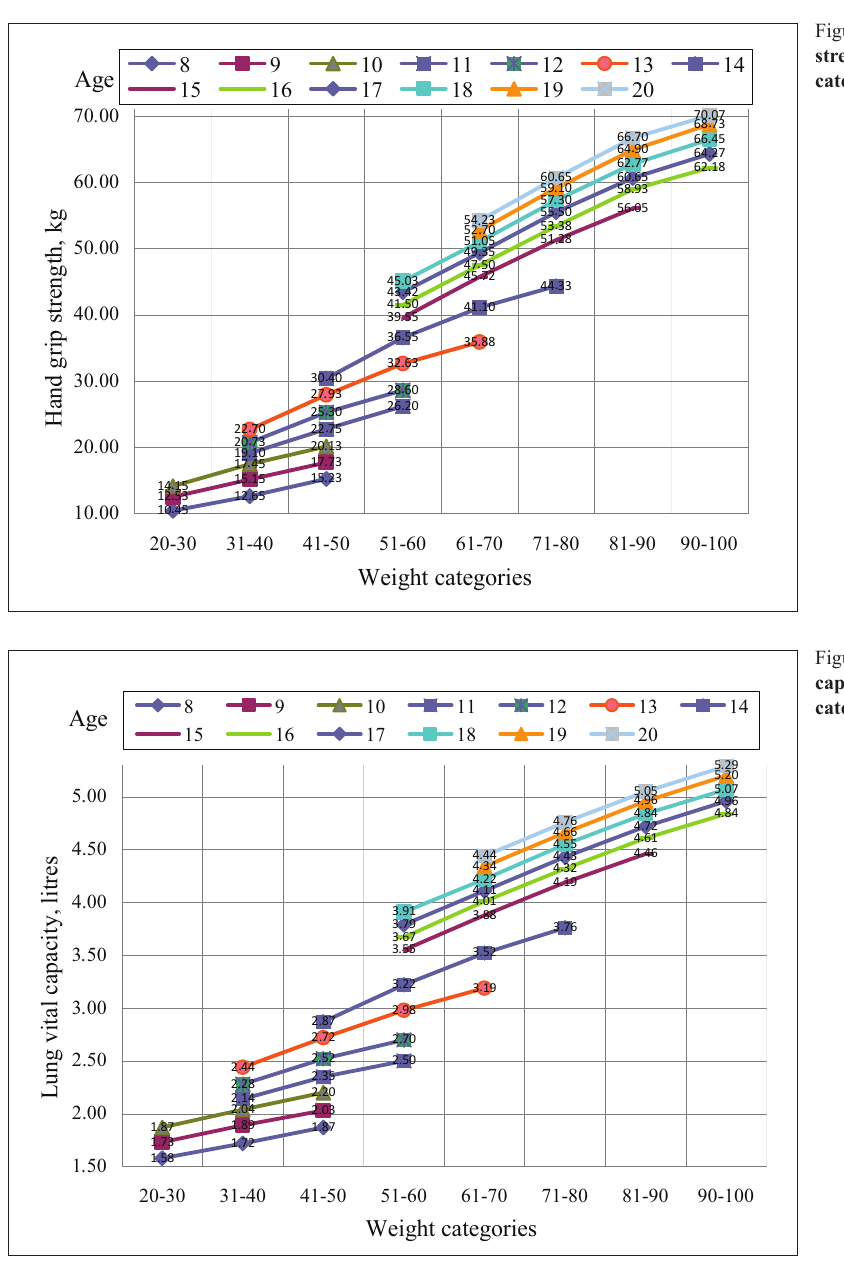
Figure 1. The mean value of hand grip strength in different age and